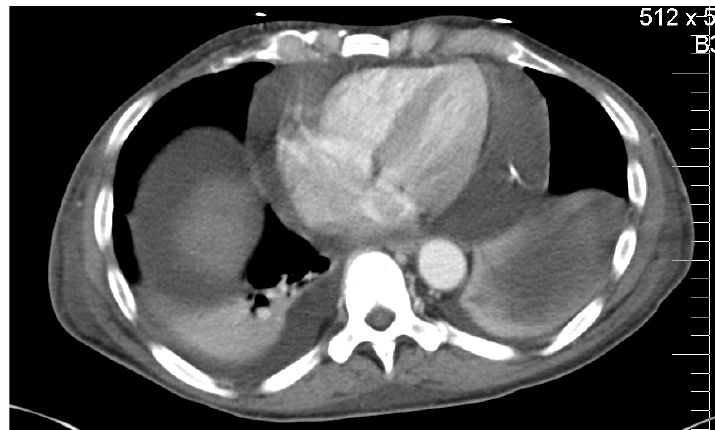
Figure 1. CT Chest. Large pericardial and pleural effusions. The tip of the drain is shown in the pericardial